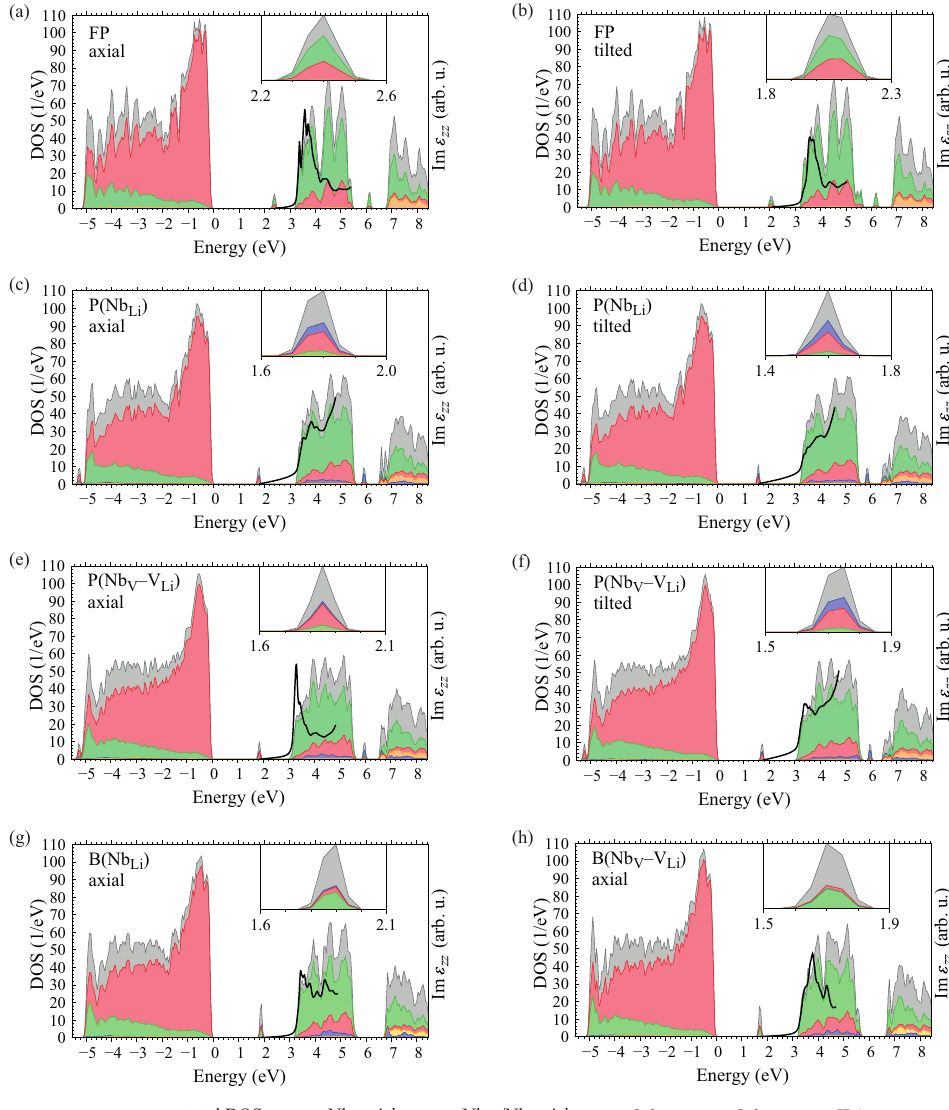
Figure 5. Electron densities of states for the free polaron ( a , b ), the bound polaron at a Nb Li antisite defect ( c , d ) or a Nb V –V Li defect pair ( e , f ), and the bipolaron at Nb Li ( g ) or Nb V –V Li ( h ). Subfigures ( b , d , f ) refer to tilted configurations, all other structures exhibit axial symmetry. The thick black line shows the imaginary part of ε zz ( ω ) within the independent-particle approximation (IPA), whose low-energy resonances correspond to transitions from the defect state into the conduction